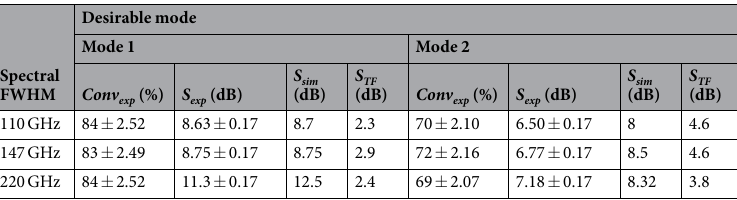
Table 2. Conversion efficiency and selectivity in high conversion regime. Measurement and simulation results for pulses 100% overlapping in spectral domain. S TF : Simulated Selectivity for the TF